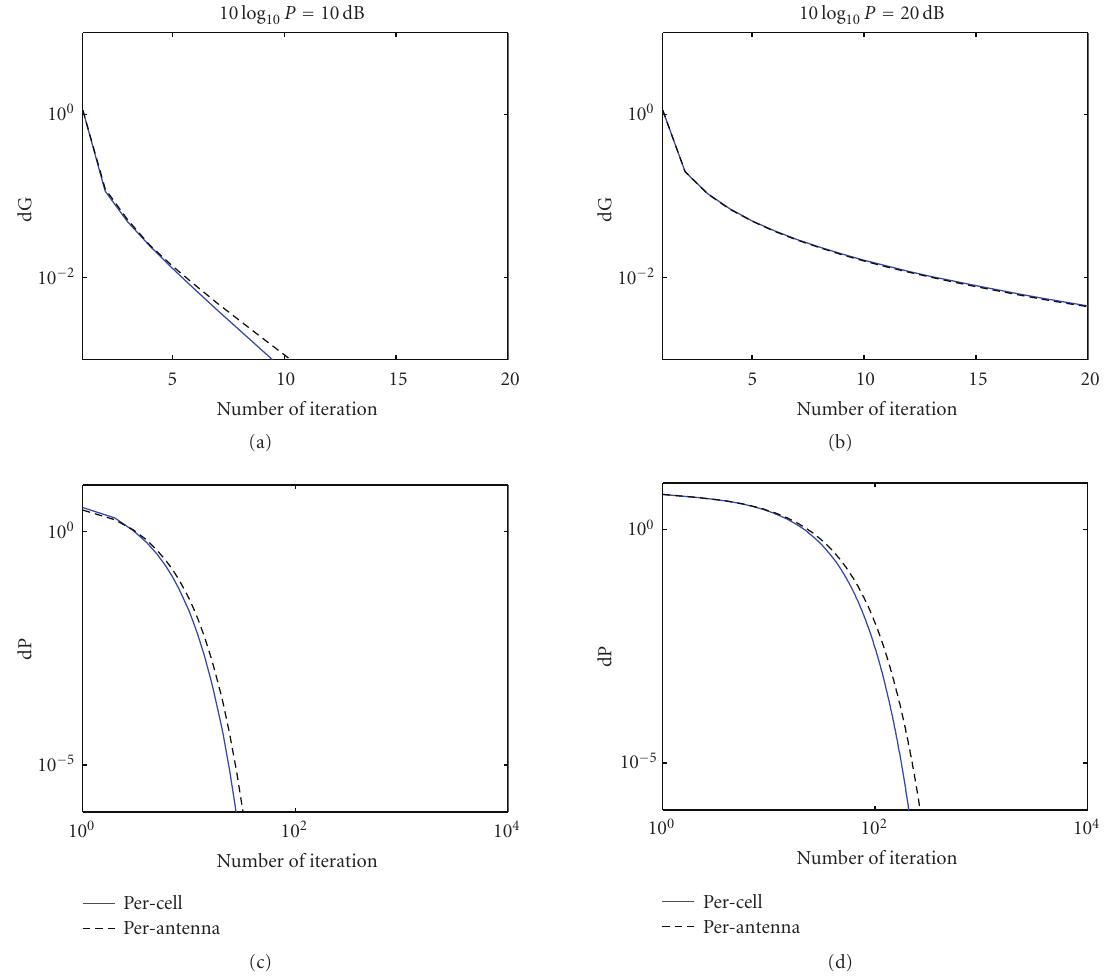
Figure 3: Convergence of the GIA ( FIA ): the di ff erences dG and dP, defined in (42), as functions of the number of iterations under the per-antenna and per-cell power constraints. System parameters are given in example 1 of Table